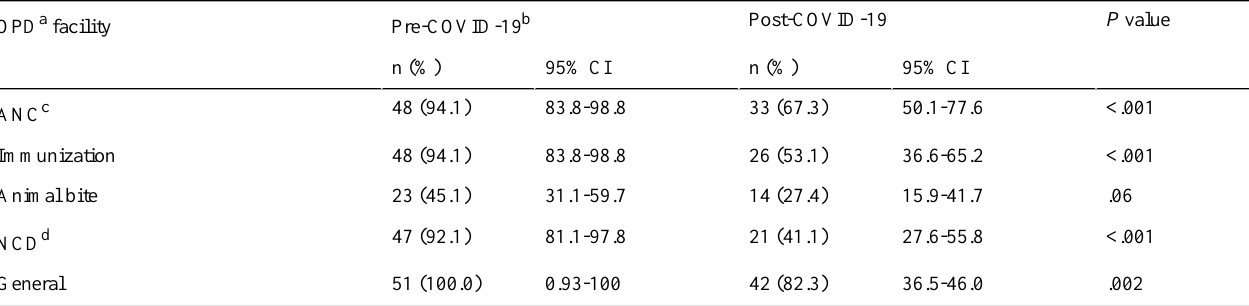
Table 1. Comparison of outpatient services (N=51) functionality during the COVID-19 epidemic in India during the study period (April 24-30, 2020).